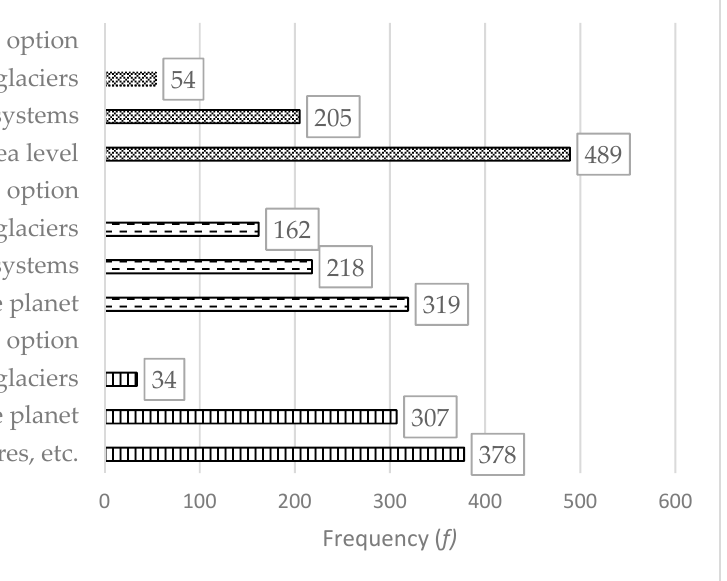
Figure 3. Response options regarding the consequences of climate change. Source: Results of the questionnaire Own elaboration.